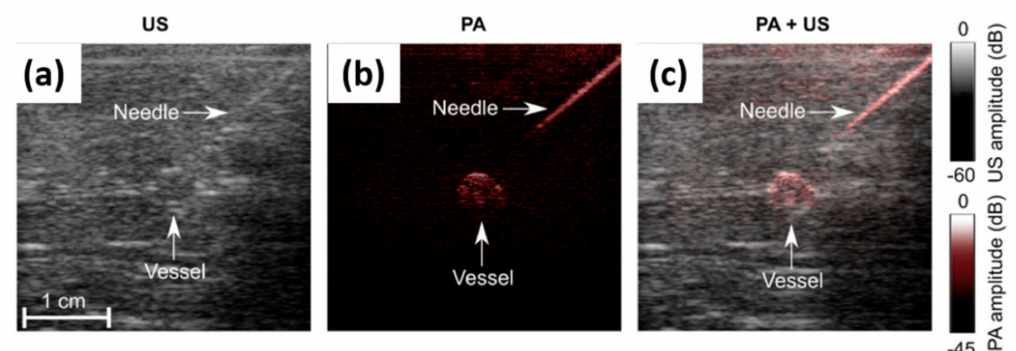
Figure 2. ( a ) US, ( b ) PA and ( c ) US-PA overlay images showing a medical needle inserted towards a vessel-mimicking phantom embedded in chicken tissue, respectively. Here, the uppermost 5 mm, which contained the US gel, is not shown. Reprinted from Ref.